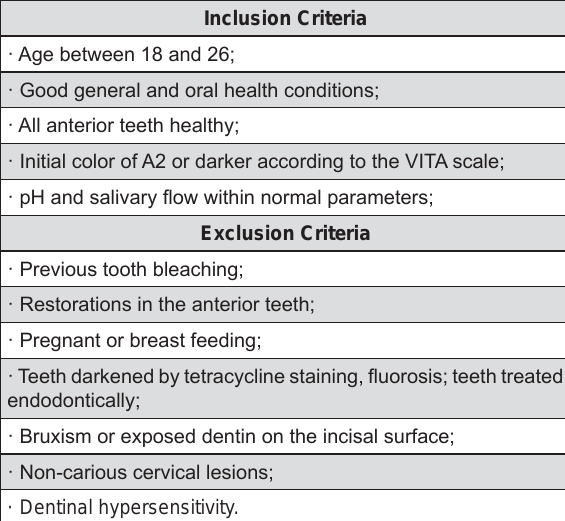
Figure 1- Inclusion and exclusion